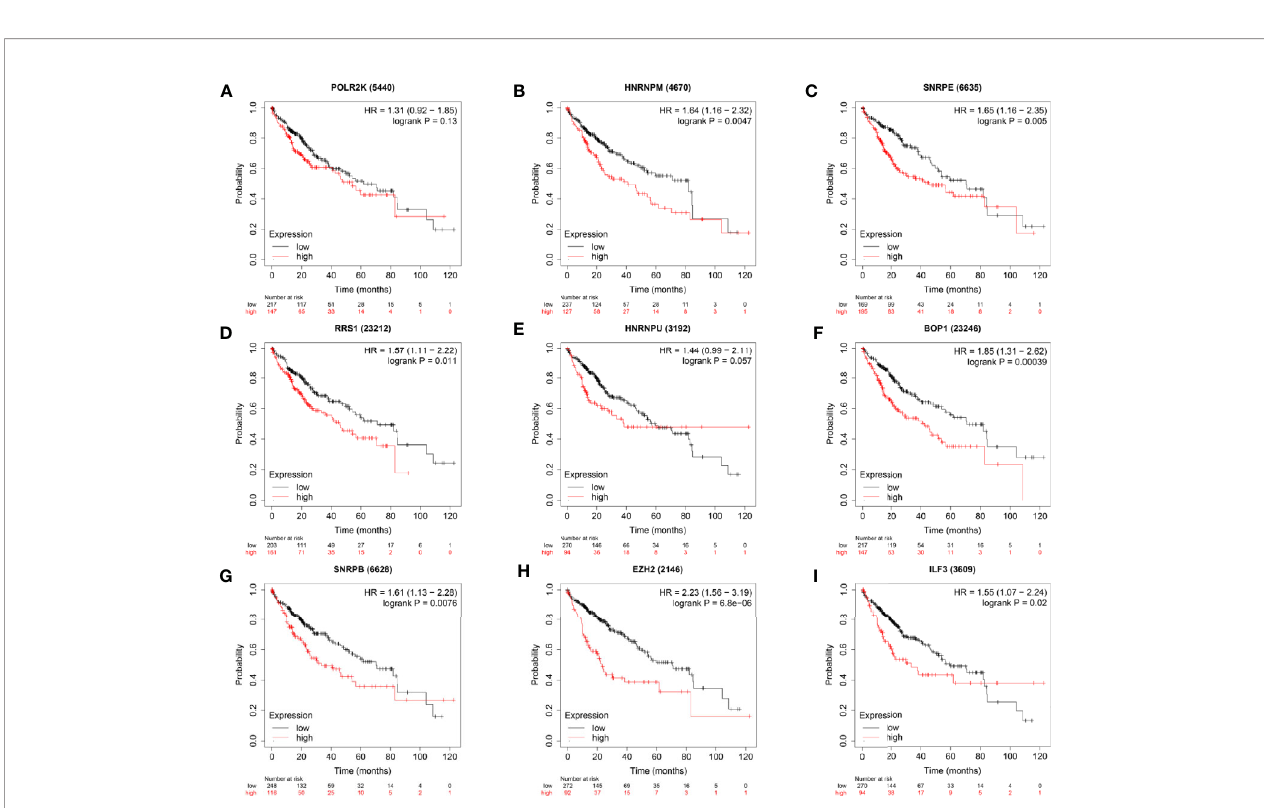
FIGURE 5 | Survival analyses of the hub genes in patients with HCC (Kaplan – Meier Plotter). P < 0.05 was considered statistically signi fi cant.